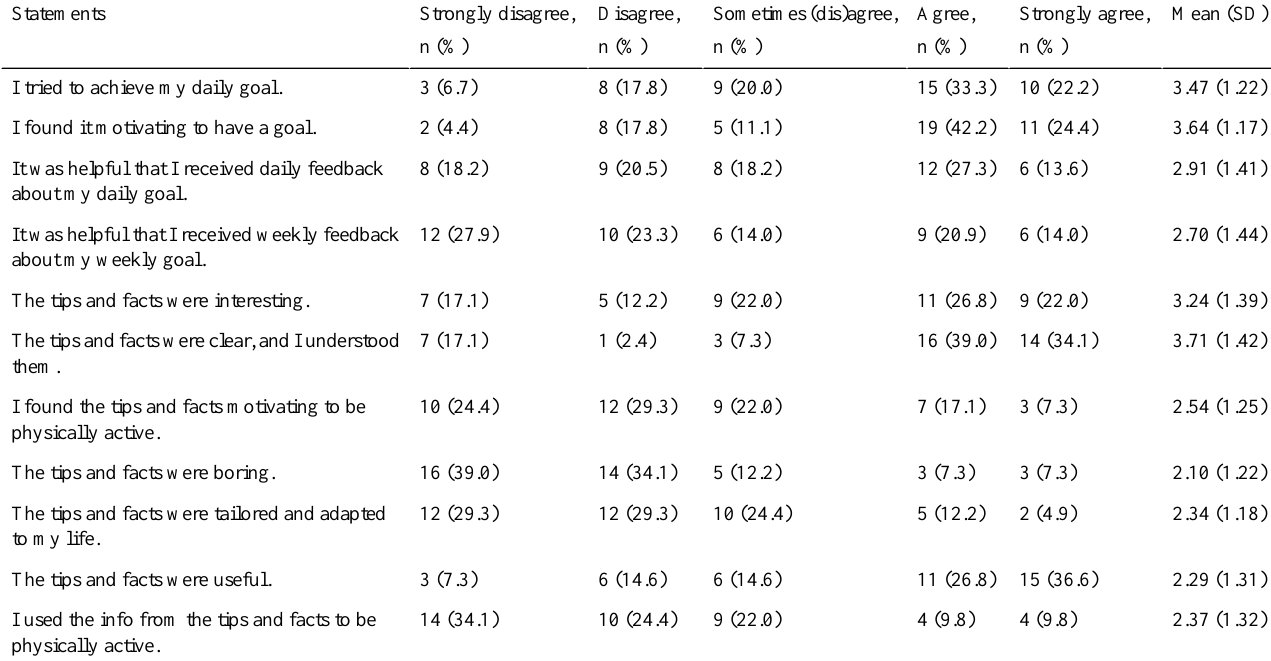
Table 6. Statements about goals, tips, and facts of the Active Coach app in the intervention group.